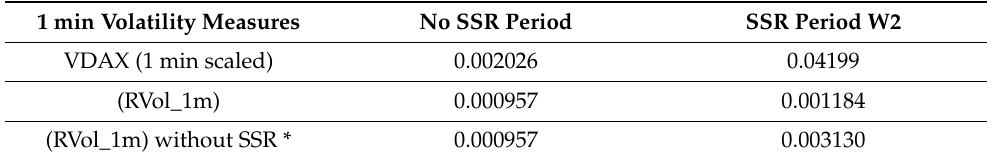
Table 3. Volatility. Difference in differences.